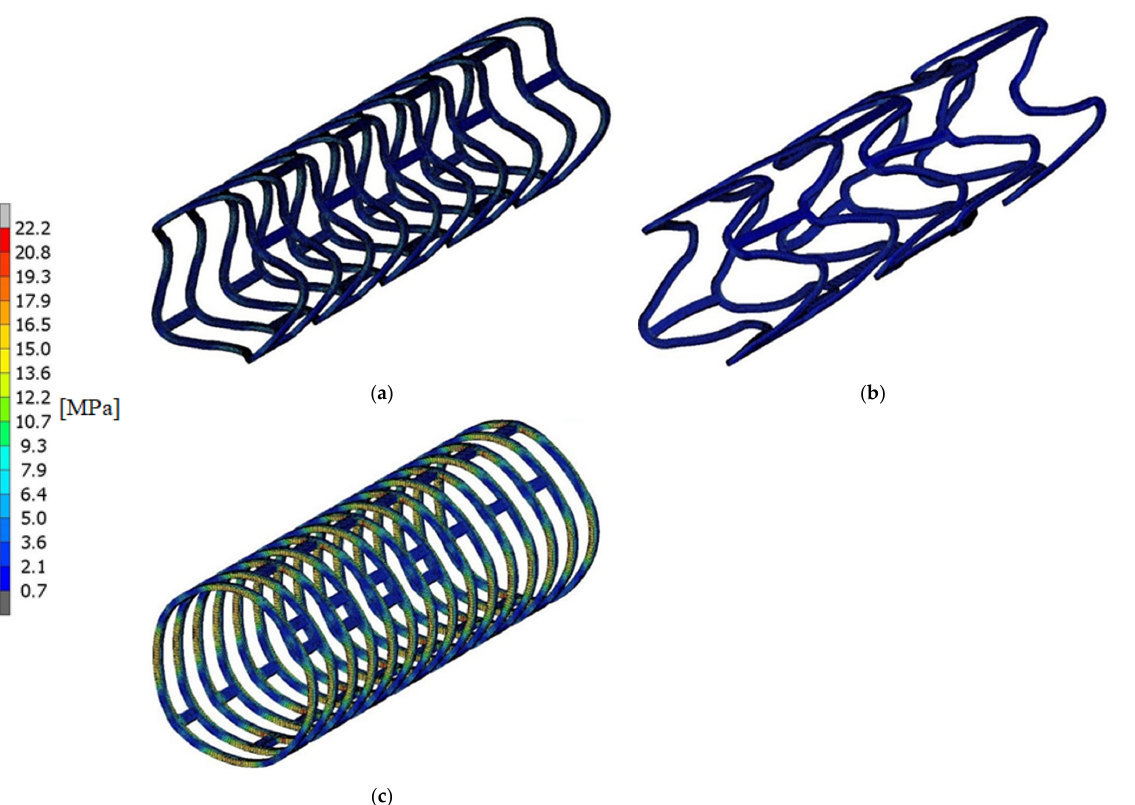
Figure 8. Stress state after stent deployment: ( a ) optimal, ( b ) too long, ( c ) too short (von Mises) .